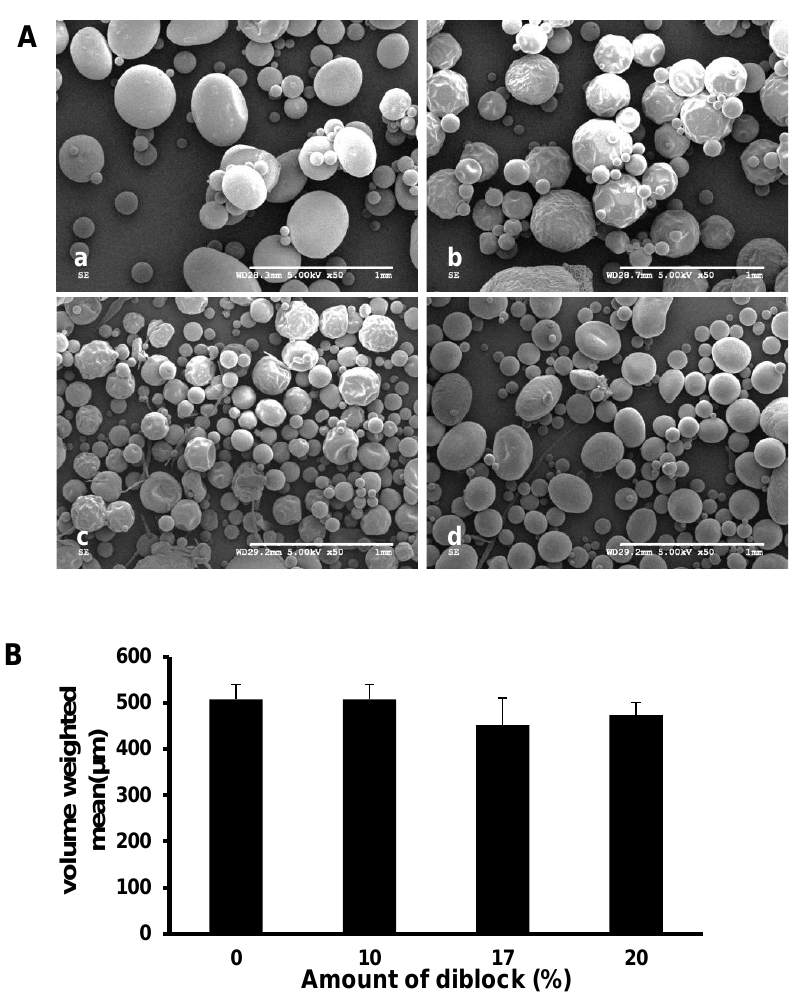
Figure 1. Scanning electron microscopy images and size distribution of different formulations of PLGA microspheres. ( A ) SEM images of KynA loaded PLGA microspheres fabricated without